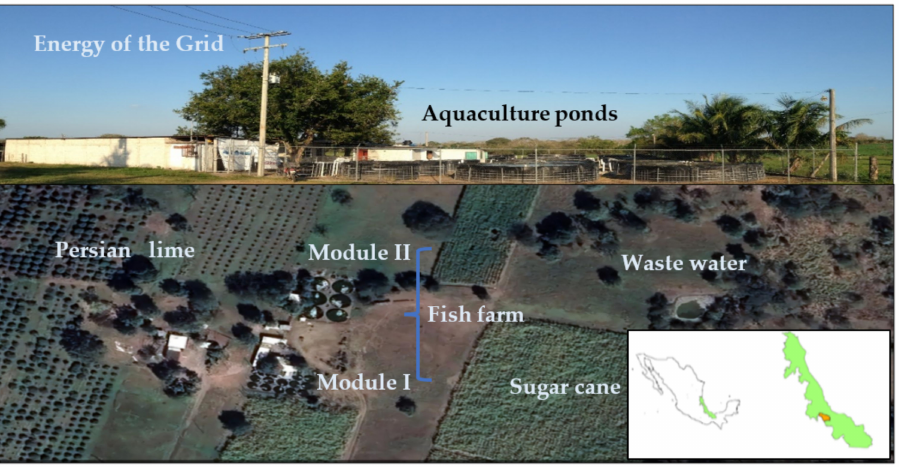
Figure 6. Location of the study site and analysis unit: Tierra Adentro fish